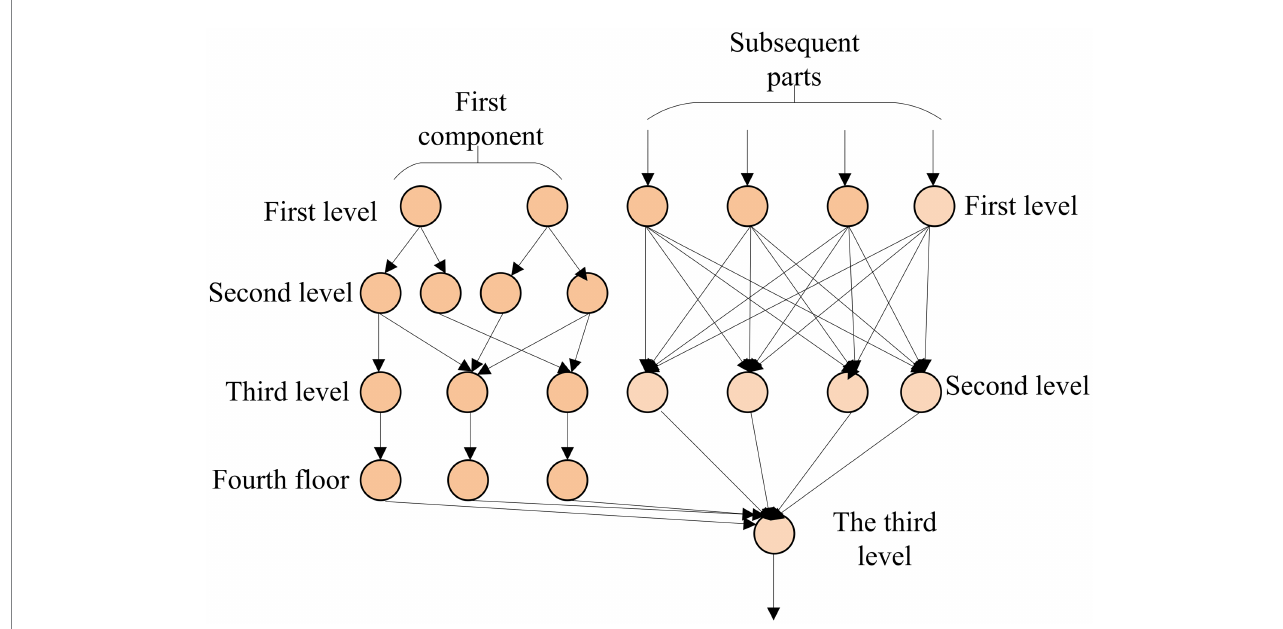
FIGURE 4 The structure of a multilayer perceptron.